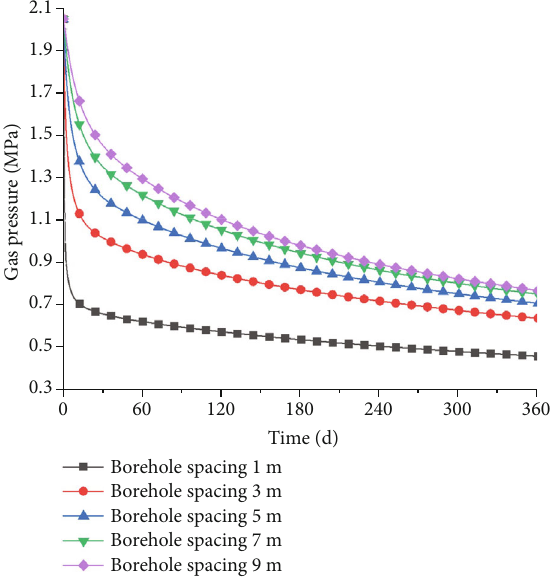
Figure 20: Gas pressure evolutions of monitoring point in fully pressure-relief zone.